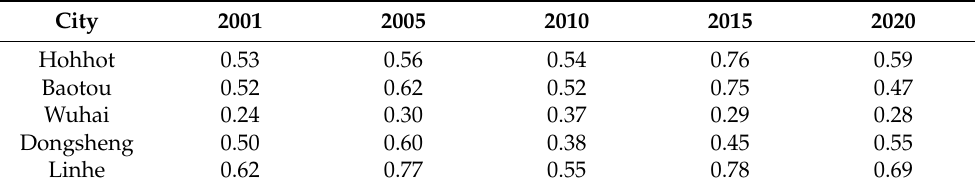
Table 1. Average urban RSEI along the Yellow River, Inner Mongolia